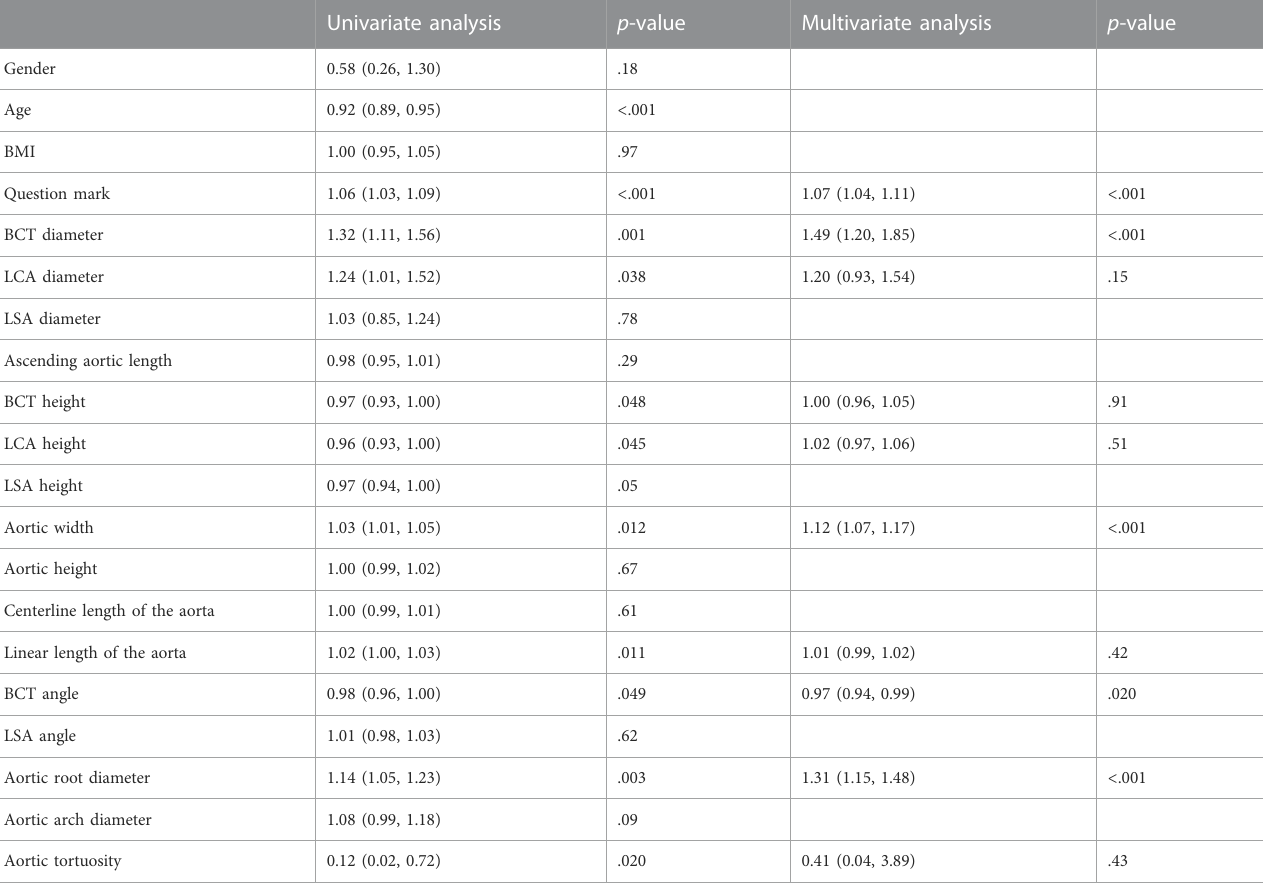
TABLE 2 Results of univariate and multivariate logistic regression analysis regarding the risk of TBAD in the overall population. Univariate analysis p -value Multivariate